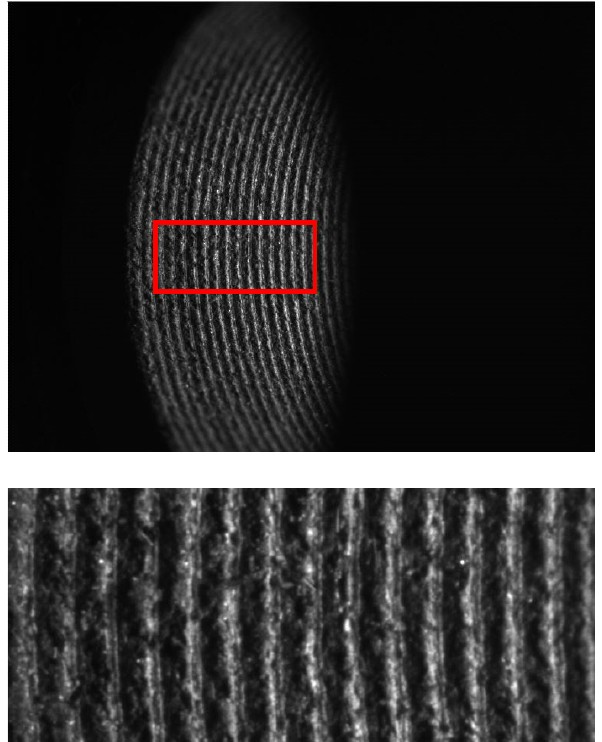
Figure 5. Captured image with marked ROI ( top ) and extracted part of the image ( bottom ).